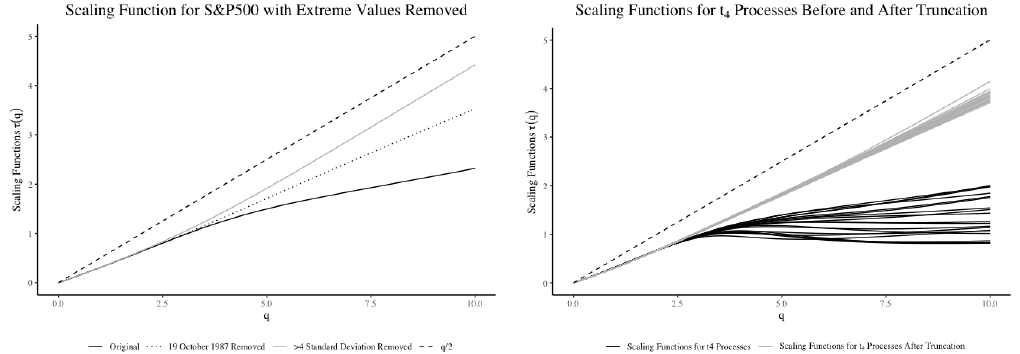
Figure 2. Left —Scaling Functions of the original S&P 500 open price data (black solid line), the S&P 500 open price data after removing 19 October 1987 (dotted line), the S&P 500 open price data after truncating any return larger than 4 standard deviations from the mean (grey solid line). Right —Scaling Functions of the Student t -distributed processes before (black lines) and after truncation (grey lines). For comparison, the reference lines q /2 (black dashed line) are